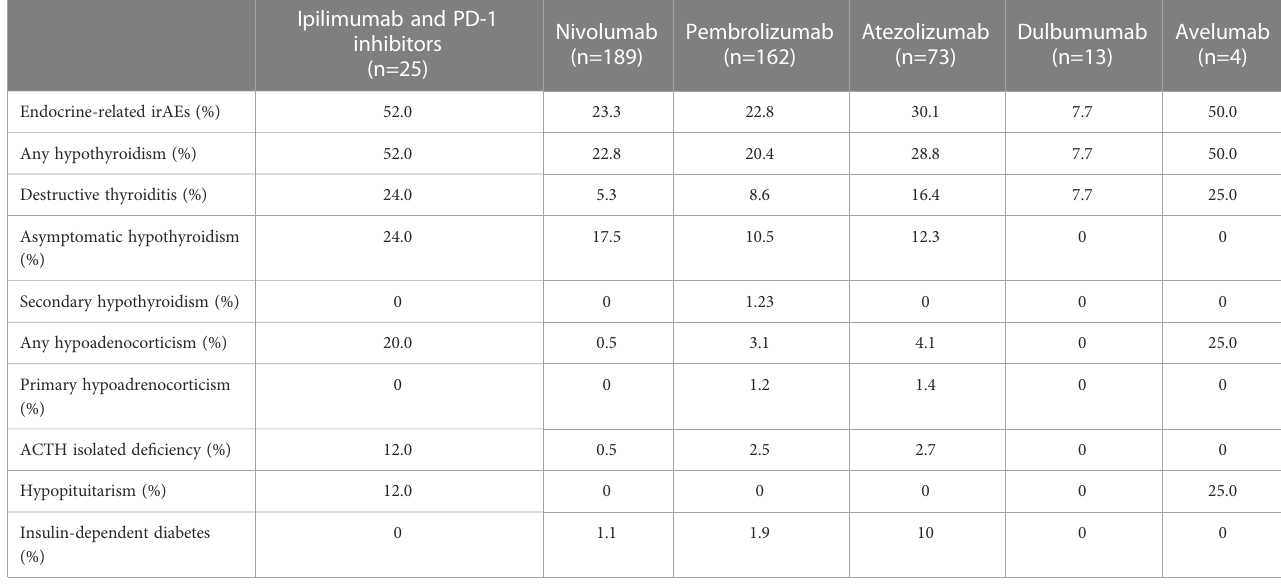
TABLE 3 Prevalence of endocrine-related immune-related adverse events after treatment with various immune checkpoint